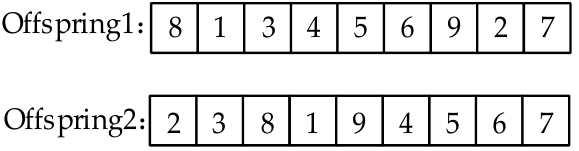
Figure 8. Results for order crossing operators.